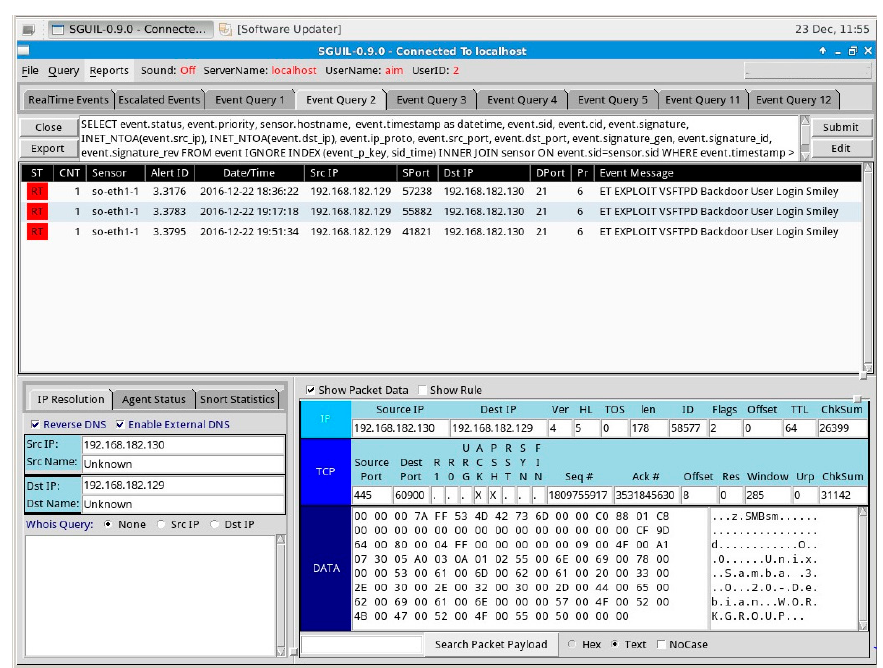
Figure 8. Sguil Console: VSFTD Smiley Face Attack Alert.